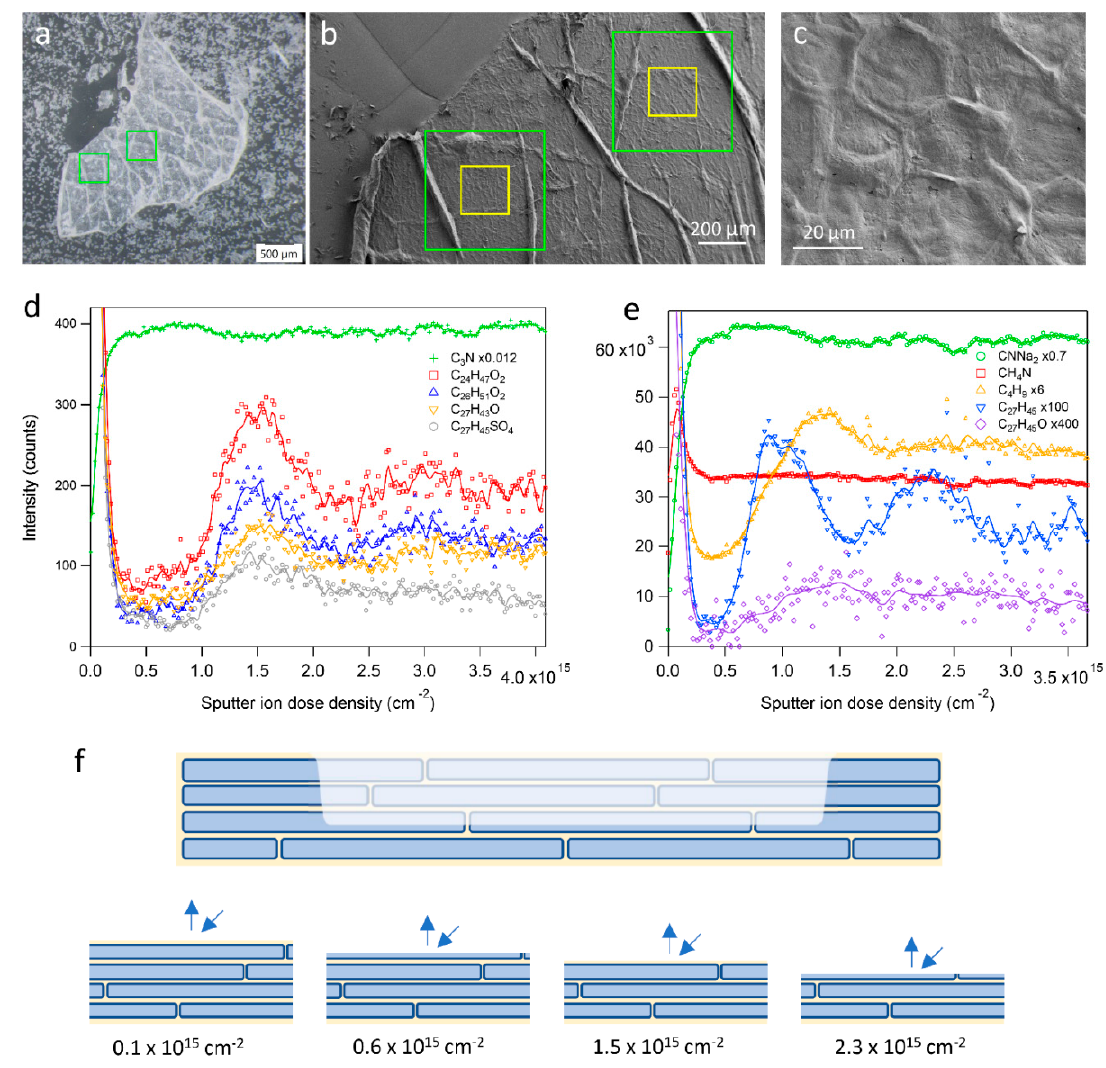
Figure 1. 3D ToF-SIMS analysis of SC multilayer fragment. ( a ) Light microscopy and ( b , c ) SEM images of the SC fragment deposited on the tape surface after tape stripping. Squares in ( b ) indicate sputter and analysis areas (green and yellow, respectively) for the 3D ToF-SIMS analyses presented here. The magnified image in ( c ) is from inside the left analysis area in ( b ). ( d ) Depth profiles of negative ions representing proteins (C 3 N − ), C24:0 and C26:0 fatty acids (C 24 H 47 O 2 − and C 26 H 51 O 2 − , respectively), cholesterol (C 27 H 43 O − ) and cholesterol sulfate (C 27 H 45 SO 4 − ). ( e ) Depth profiles of positive ions representing proteins (CNNa + and CH 4 N + , respectively), lipid fragment (C 4 H 9+ ), and cholesterol-related ions (C 27 H 45+ and C 27 H 45 O + , respectively). Symbols are acquired data points and lines are results after digital smoothing of the data. Some data were multiplied by factors (as indicated) to improve visibility. The horizontal axis corresponds to sample depth, here represented by the applied sputter ion dose density. ( f ) Schematic representation of the 3D analysis of the corneocyte multilayer sample. Successive removal of material from the sample surface exposes alternately the lipid phase and the corneocyte interior, which were monitored separately due to the strong surface sensitivity of